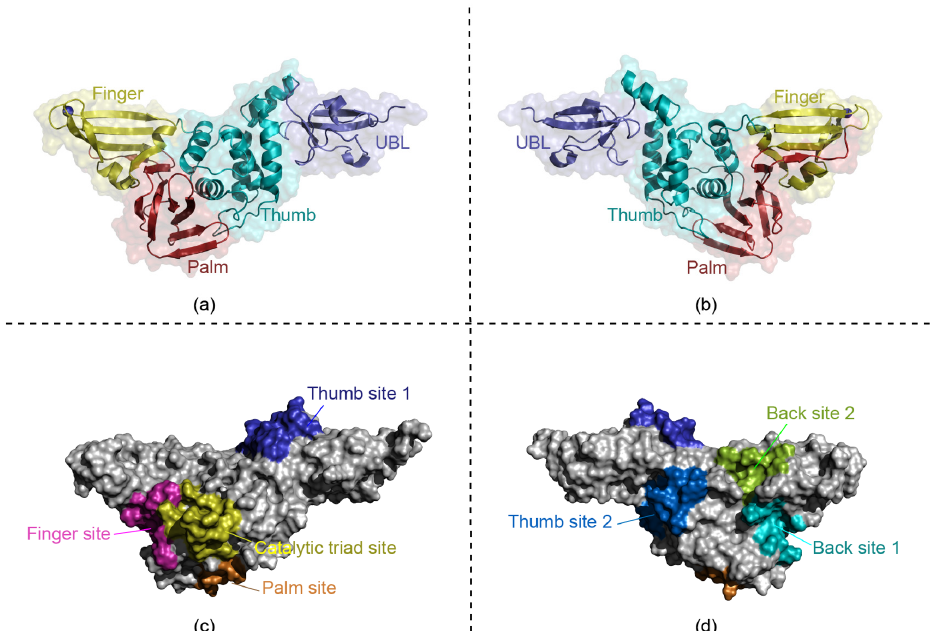
Figure 1. Domain division of the SARS-CoV-2 PLpro structure: ( a , b ) show the division of domains of SARS-CoV-2 PLpro. The blue is the UBL domain (residues 1–60), the cyan is the thumb domain (residues 61–180), the yellow is the finger domain (residues 181–238), and the red is the palm domain (residues 239–315). ( c , d ) show the locations of the main sites mentioned in the article, including the catalytic triad site, thumb site 1, thumb site 2, palm site, back site 1, back site 2 and finger site. According to previous literature reports and information from the Protein Databank (PDB), there are several known SARS-CoV-2 PLpro targets, a canonical cysteine protease catalytic triad site (PDB ID: 6WUU, 7CJM) [19–21], a thumb region binding site (PDB ID: 7OFS), and a lower palm region binding site (PDB ID: 7M1Y). We named them the